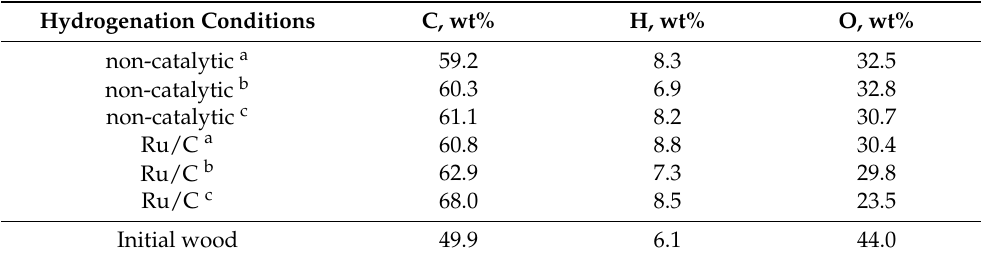
Table 3. Elemental composition of liquid products of hydrogenation of the initial ( a ), alkali-pretreated ( b ) and acid-pretreated ( c ) birch wood.